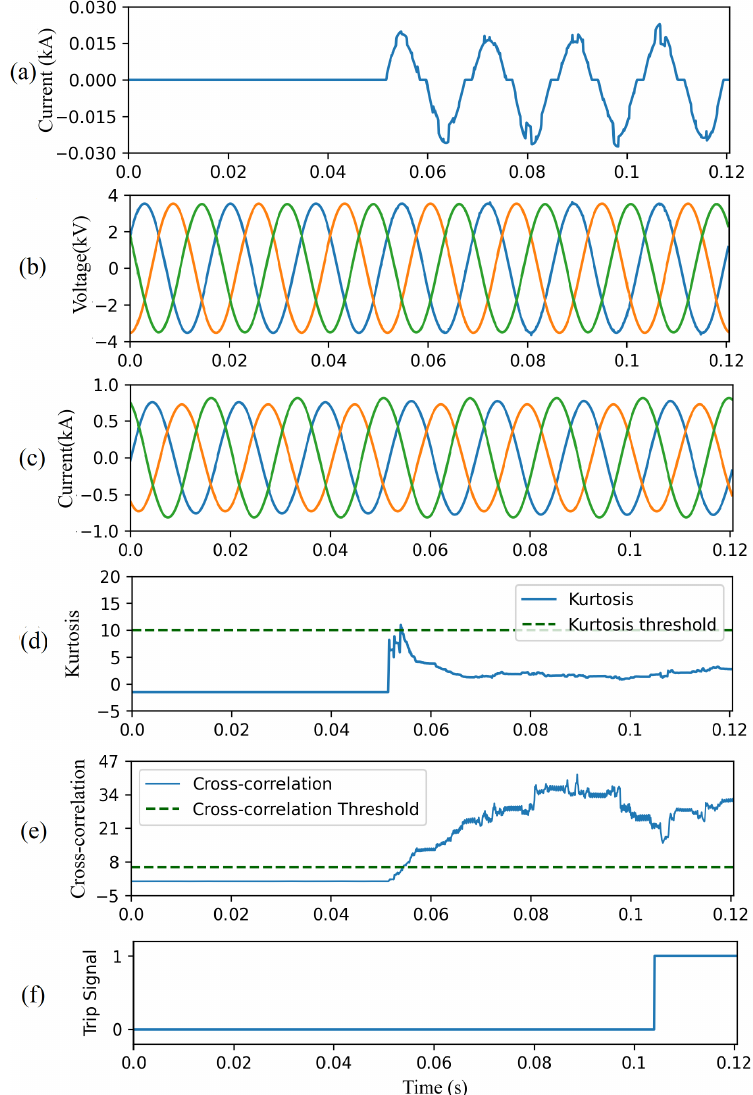
Figure 12. CAE-HIFD performance under normal and remote HIF conditions: ( a ) HIF current, ( b ) three-phase input voltages, ( c ) three-phase input currents, ( d ) kurtosis, ( e ) cross-correlation, and ( f ) trip